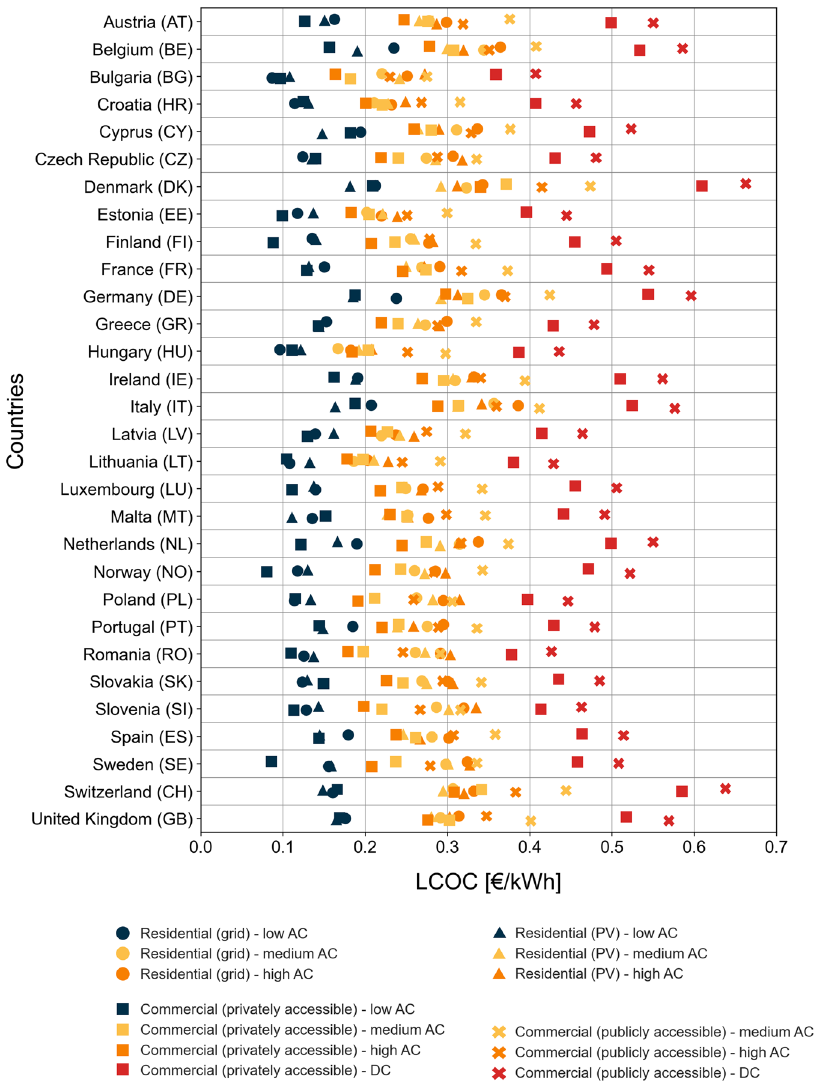
Fig. 3 | Chart ofLCOCresultsin € per kWh ofenergy chargedofdifferent charging optionsin allanalyzed countries. Source dataare providedasaSource Data fi